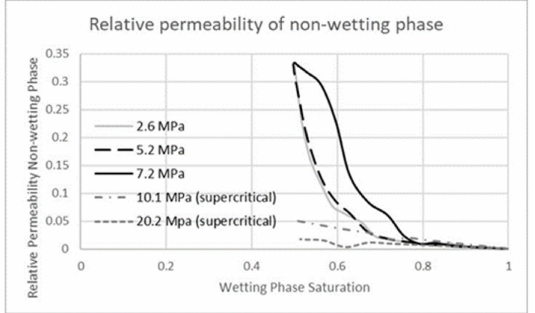
Figure 19. Relative permeability of non-wetting phase versus wetting phase